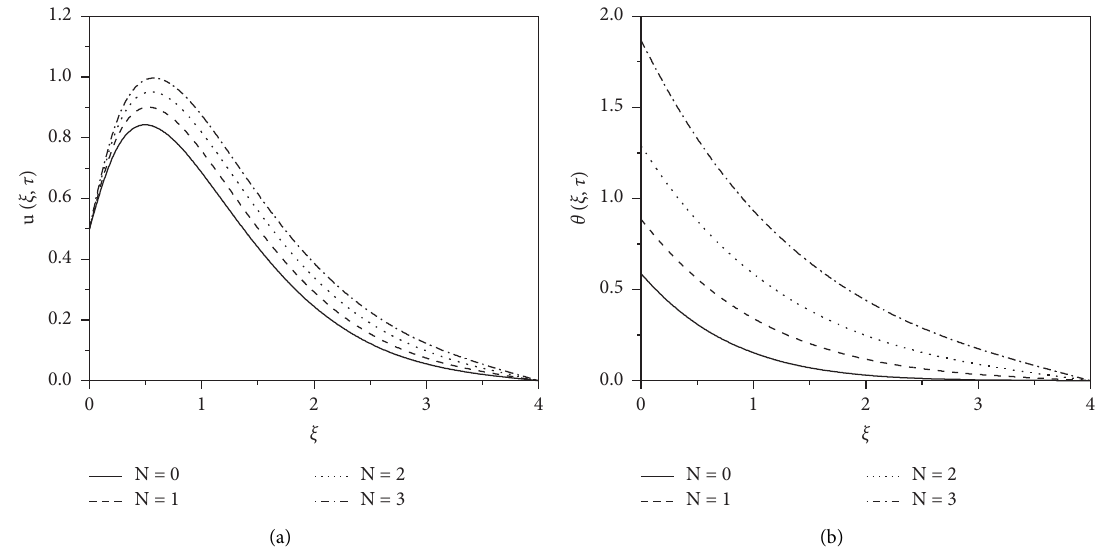
Figure 4: Variation of (a) velocity u ( ξ , τ ) and (b) temperature θ ( ξ , τ ) against ξ for various values of N